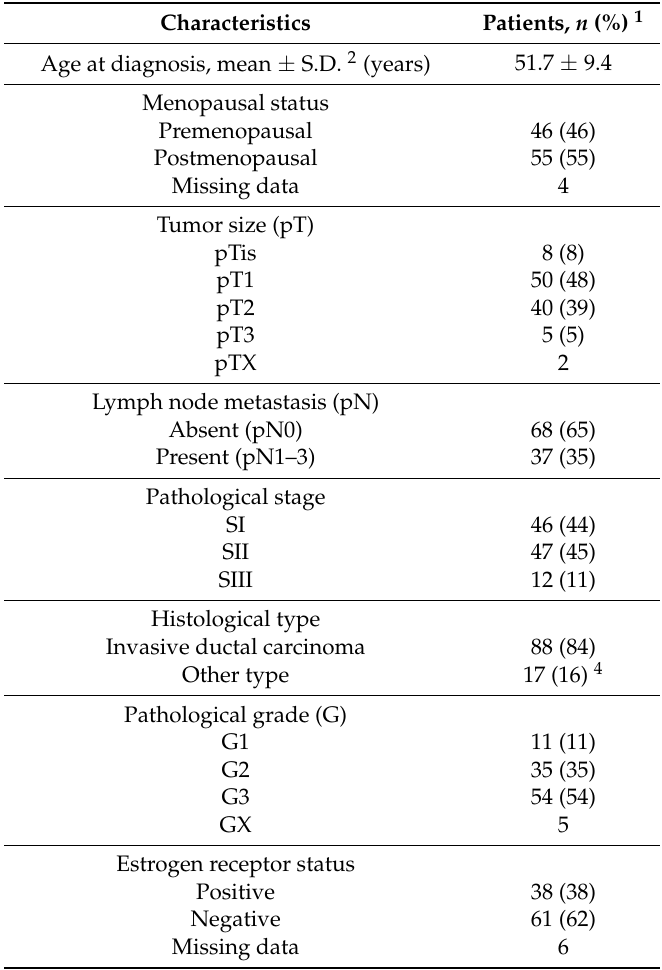
Table 1. Clinical data of patient in the testing